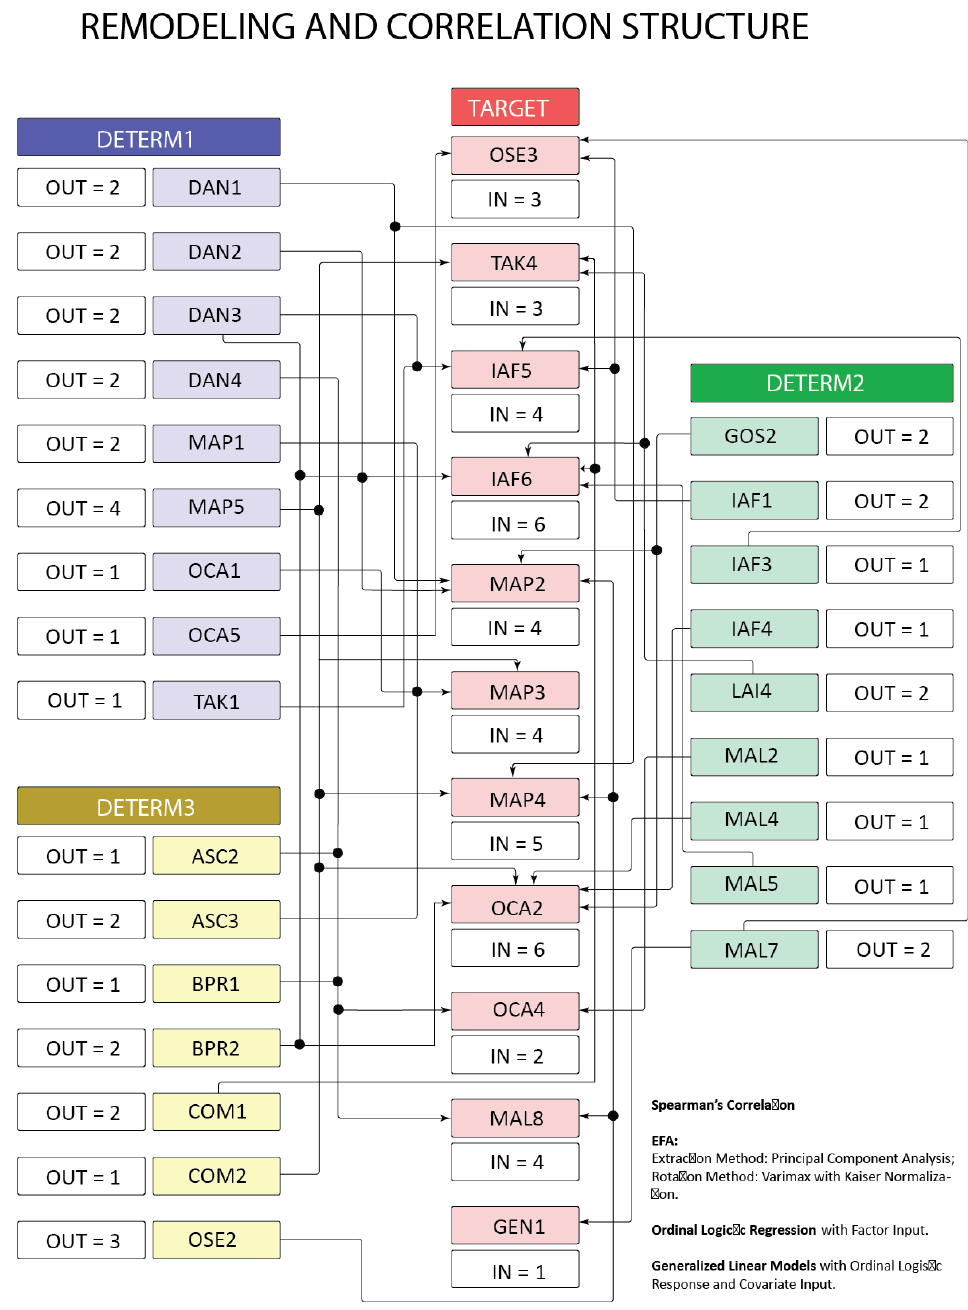
Figure 5. Correlation model between determinants and OSC success in Southeast Asia after the pandemic.